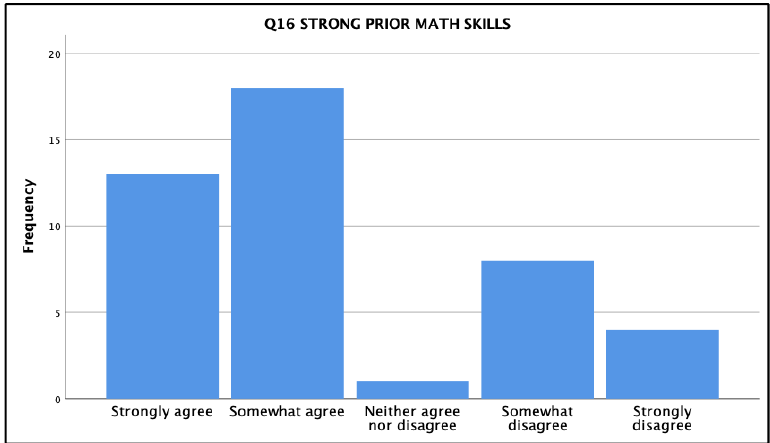
Figure 4. Q16 survey results regarding participants’ perceptions of their own math skill strengths reflecting back on when they entered the program.